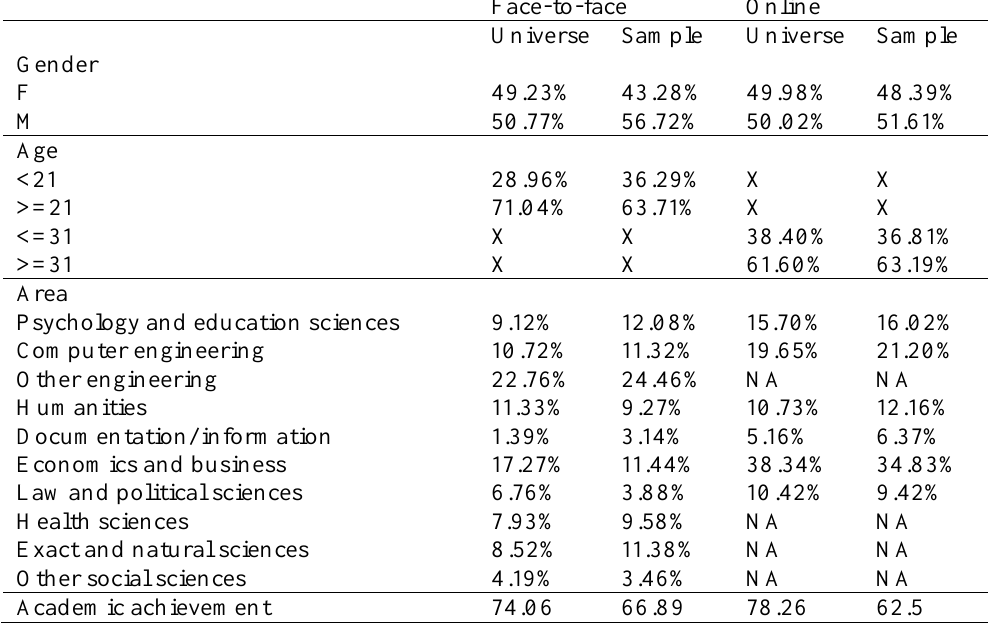
Table 1 Comparison of Sociodemographic Characteristics and Study Areas: Universe versus Self-Selected Sample